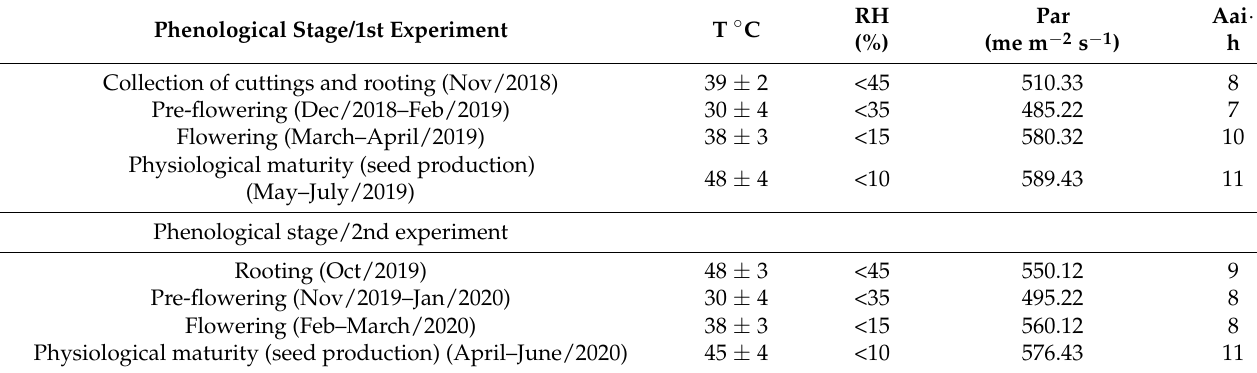
Table 2. Present conditions in the different phenological stages of S. bigelovii seed production from cuttings. Phenological Stage/1st Experiment